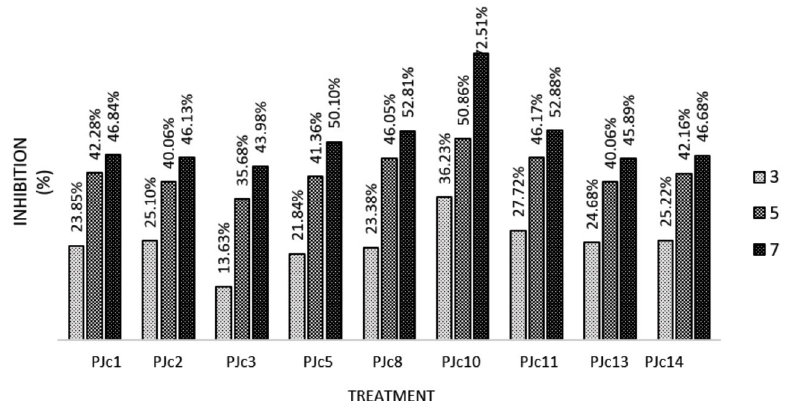
Fig. 3. Power Inhibition Assay results Endophytes of Jatropha leave ( J. curcas L.) with the pathogen F. oxysporum on 3, 5, and 7 days after incubation (DAI).